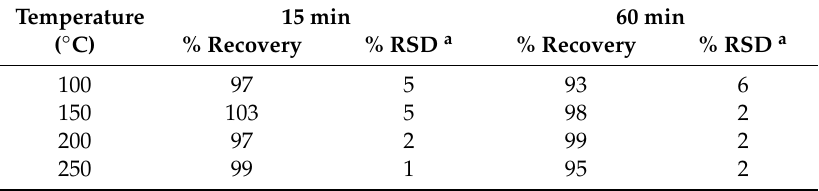
a Based on triplicate